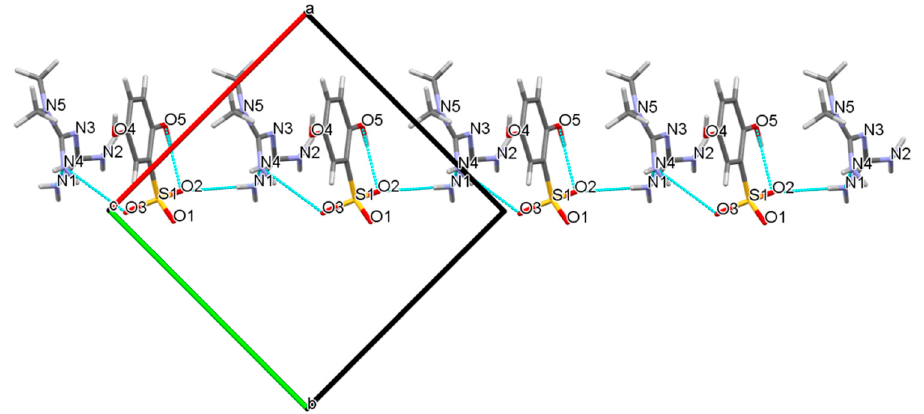
Figure 6. The one-dimensional hydrogen-bonded chain of MET–DBS viewed along the c axis.